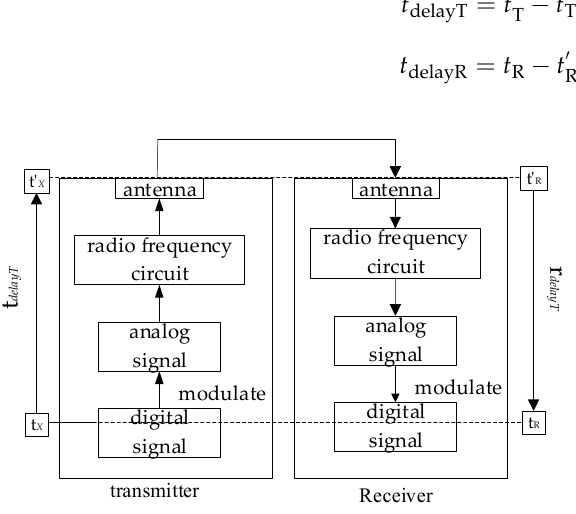
Figure 2. Decawave’s DWM1001 Development Board.